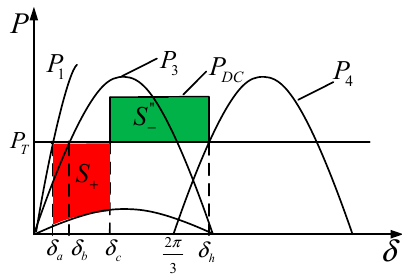
Figure 13. Generator angle characteristic with MMC-based phase sequence exchanging system.